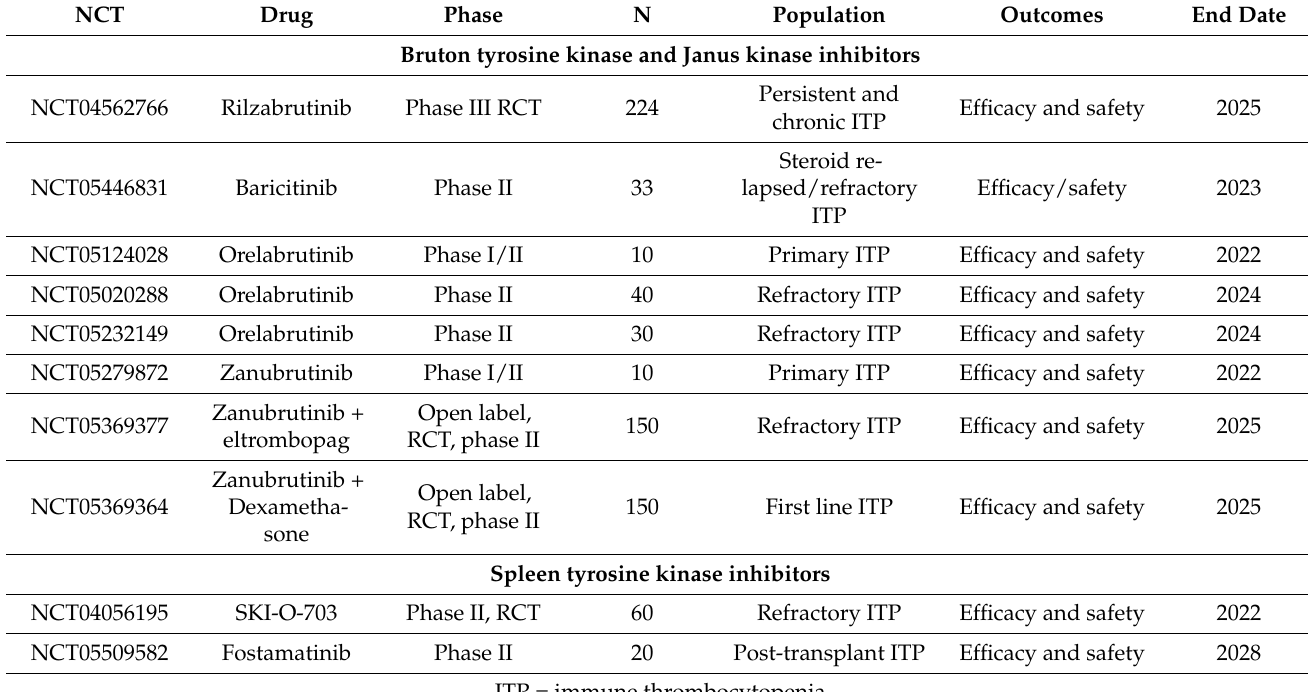
Table 3. Ongoing clinical trials on TKIs for refractory ITP registered on